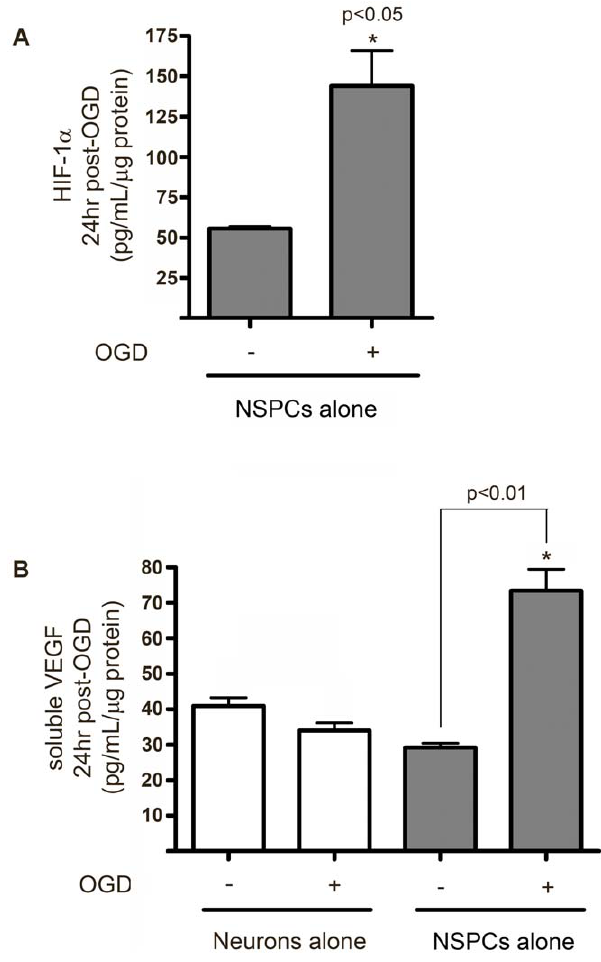
Figure 3. HIF-1 a and VEGF expression in eNSPC cultures under control vs. OGD conditions. ( A ) HIF-1 a protein levels in cell lysates from eNSPCs at 24 hrs following a 2 hr exposure to OGD or control conditions. ( B ) VEGF within neuronal or NSPC conditioned media following 2 hr exposure to control or OGD conditions. Media was conditioned for 24 hrs following exposure to OGD or control conditions. *p , 0.05, Student’s t-test, n=4 cultures/group.